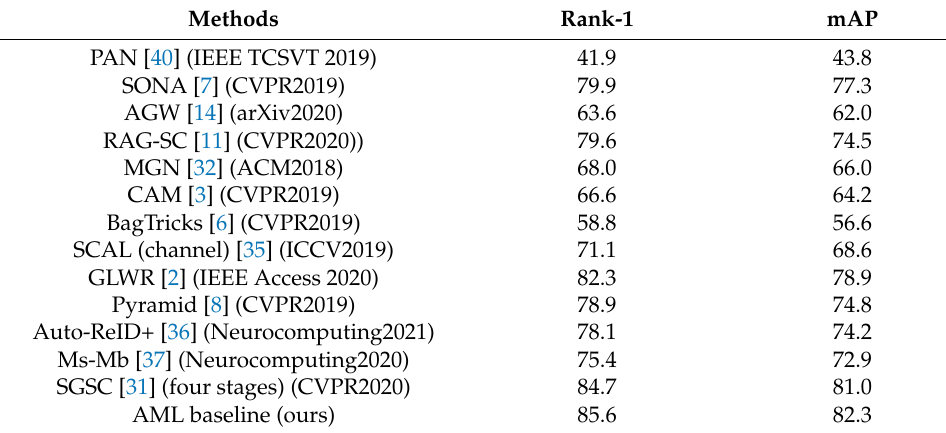
Table 6. Comparison of advanced baselines on